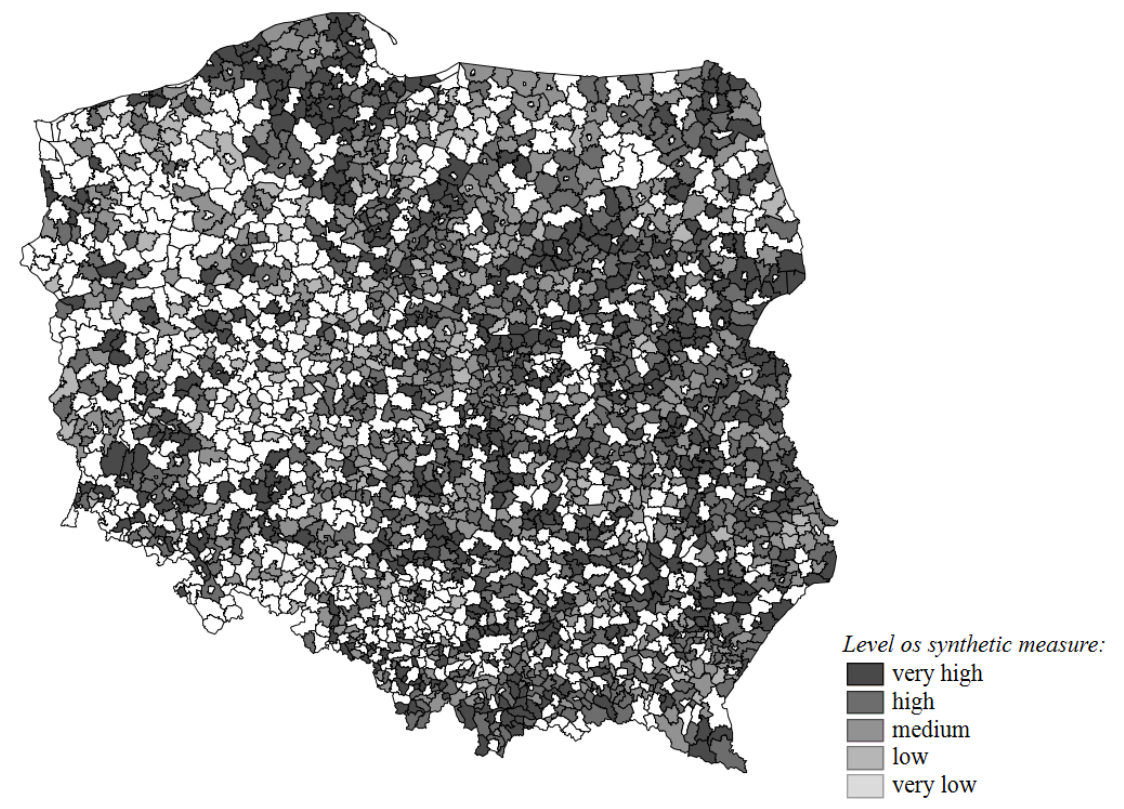
Figure 1. Spatial diversification of investment activity level of rural communes in Poland in the years 2007–2018. Legend: Urban and urban-rural municipalities not included in the survey are marked in white; typological classes were distinguished based on the value of the synthetic measure—a very high investment activity level was ascribed to municipalities with the highest values of the synthetic measure constructed, whereas a very low investment activity level was ascribed to those with the lowest values of the synthetic measure (Table 4, see Research Materials and Methods). Source: Own calculations based on Table 4. Table 4. Typological classes of the level of investment activity of rural communes in Poland in the years 2007–2018 (average